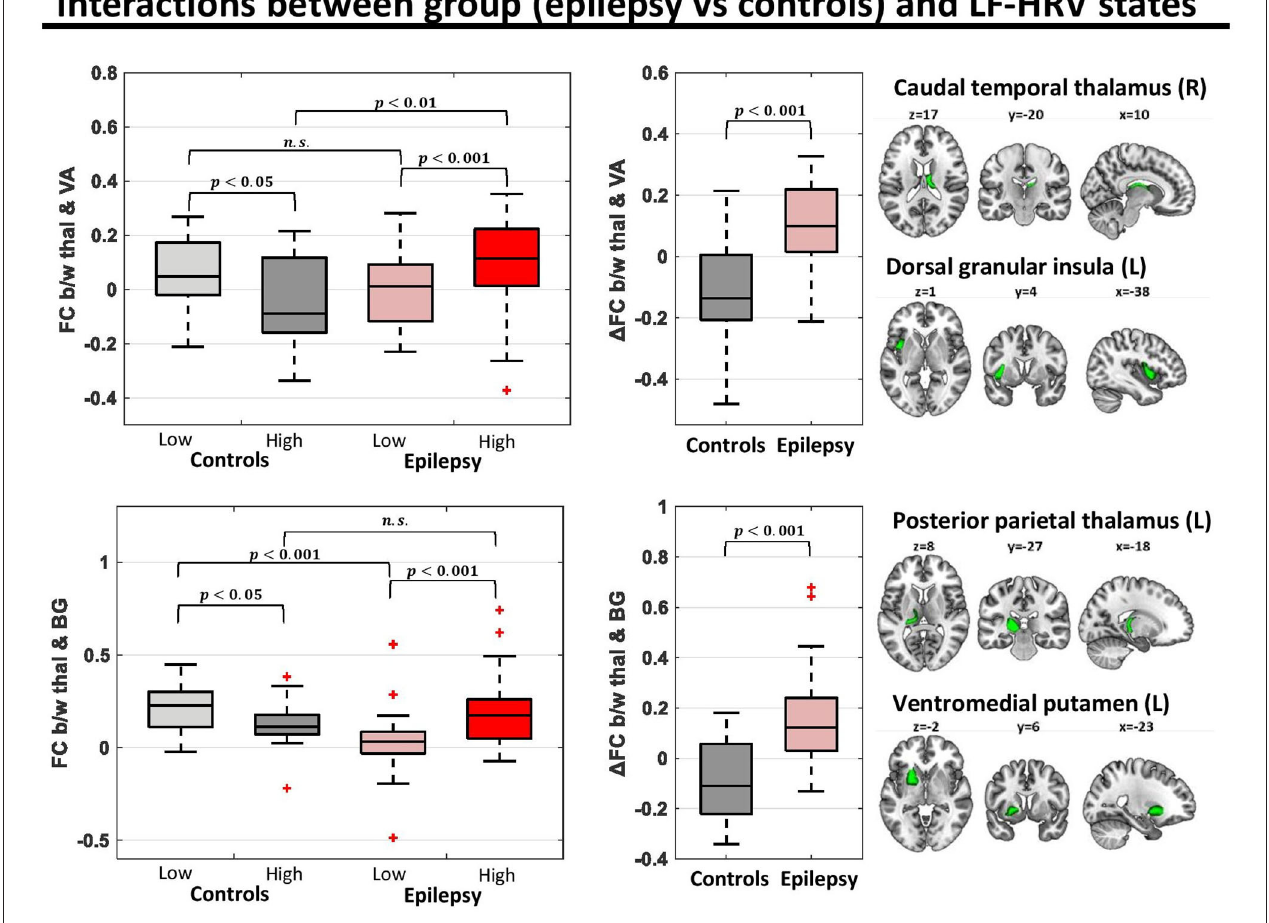
FIGURE 4 | Functional connectivity (FC) for pairs of parcels with strong group (epilepsy vs. controls)-LF-HRV interactions. In the healthy controls ( n = 16), the connectivity strength between the right caudal temporal thalamus and left dorsal granular insula [region of ventral attention (VA) network] was lower in times with high levels of LF-HRV (i.e., levels of LF-HRV in the highest quartile of a scan) compared to times with low levels of LF-HRV (i.e., levels of LF-HRV in the lowest quartile of a scan), whereas in people with epilepsy ( n = 28) the connectivity strength was higher in times with high levels of LF-HRV. Similar results were observed for the connectivity strength between the left posterior parietal thalamus and the left ventromedial putamen [region of the basal ganglia